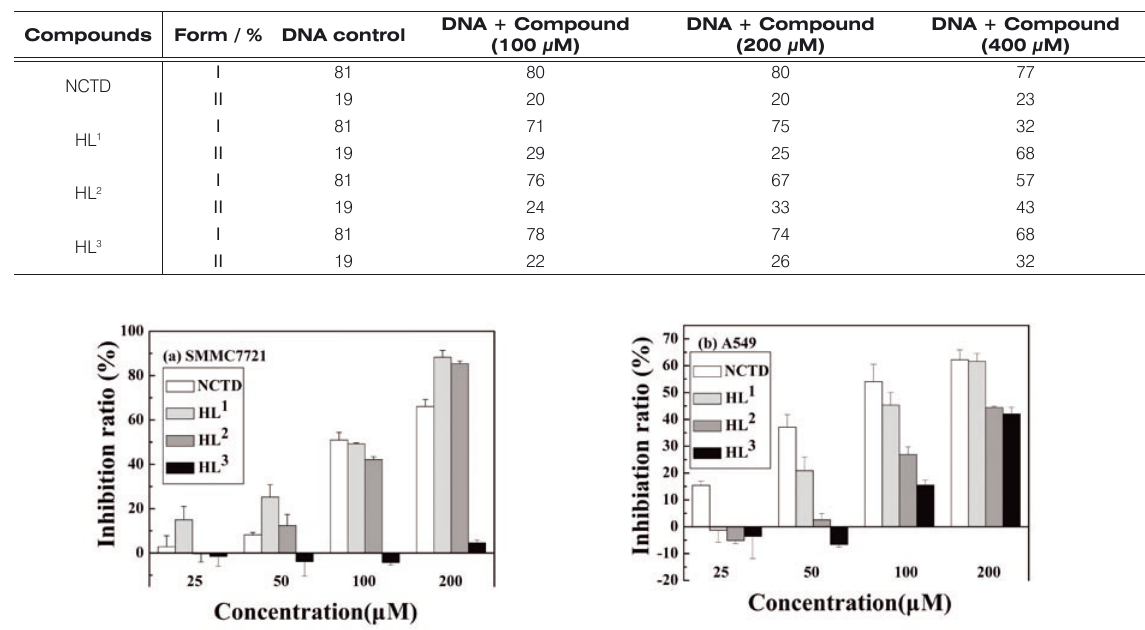
Figure 5. Effect of the NCTD and compounds at different concentrations for 72 hours on the proliferation of tumor cell. All assays were performed in triplicate for three independent experiments. (a): SMMC7721; (b): A549. Data are expressed as mean±S.D. (n = 3). Table 2. 72 h IC (μM) values of test compounds in SMMC7721 and A549 cells lines. Data represent mean±S.D. All assays were performed in 50 triplicate for three independent experiments.